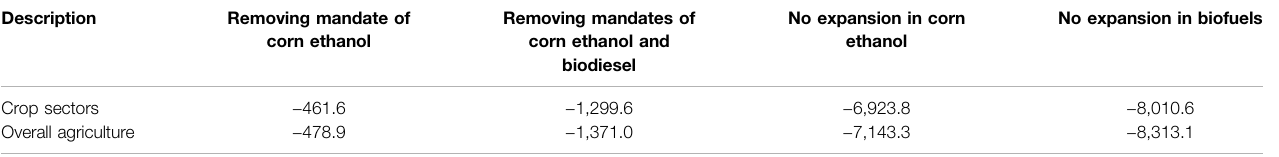
TABLE 3 | Changes in farm income with and without the RFS and biofuel changes for 2004 – 2011 (Million